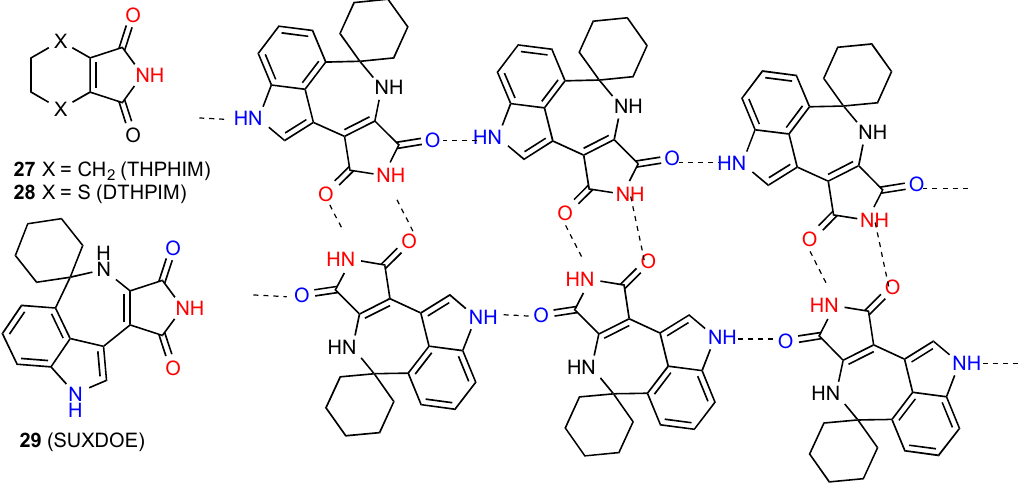
Figure 10. Structures of ring-fused maleimides 27–29.